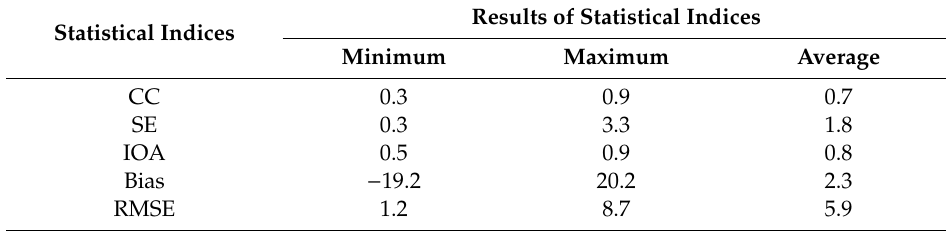
Table 1. Results of the statistical indices that were calculated to evaluate the Asian Precipitation-Highly Resolved Observational Data Integration Towards Evaluation of Water Resources (APHRODITE) precipitation